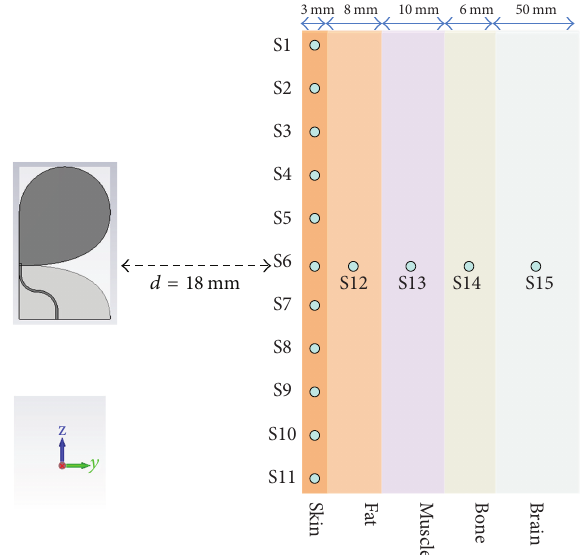
Figure 3: UWB antenna in the presence of the multilayered body model.